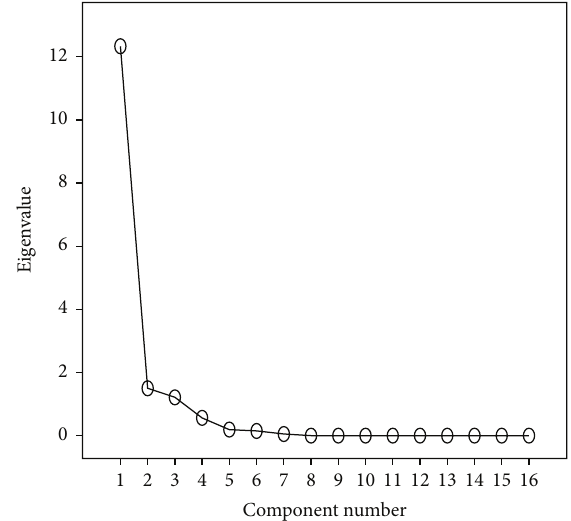
Figure 4: Scree plots of the factor model of the sampling stations.